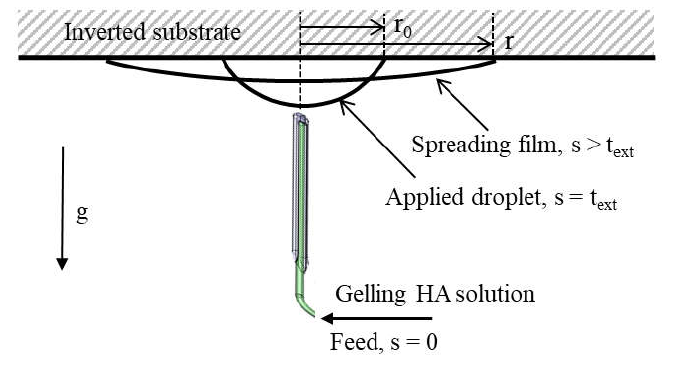
Figure 3. Film application and spreading onto an inverted substrate. s = time from inflow to syringe = t + t ext . Flow rate Q ~ 1–10 cm 3 /min.